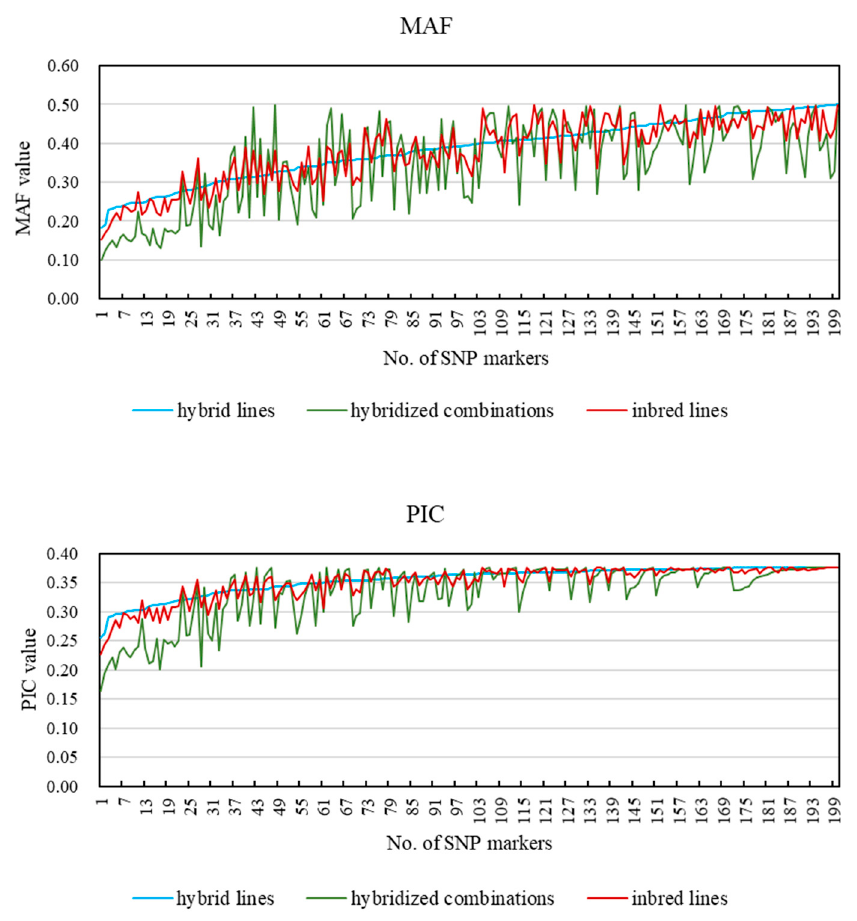
Figure 3. Distribution of minor allele frequencies (MAF) and polymorphism information content (PIC) values of 200 SNPs based on maize hybrid lines, hybridized combinations and inbred lines respectively. The No. of SNP markers in abscissa was ranked from small to large according to MAF or PIC values evaluated using hybrid lines.